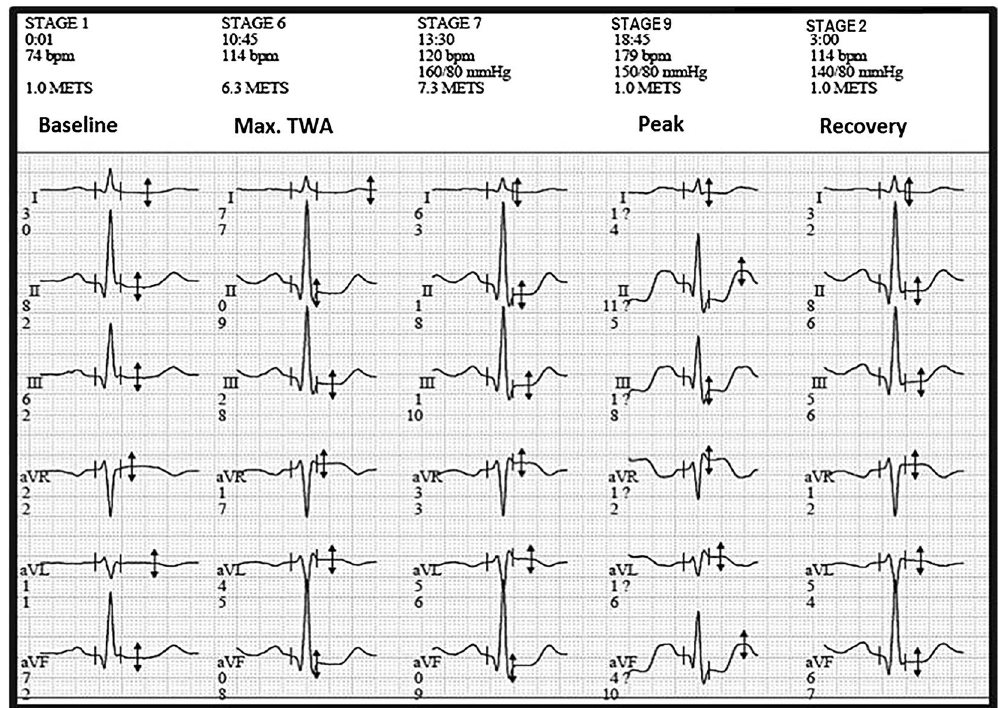
Figure 3. Aspect of the report generated at the end of the exam according to the leads and different moments of the exercise test, with the registration of TWA and noise with values expressed in microvolts